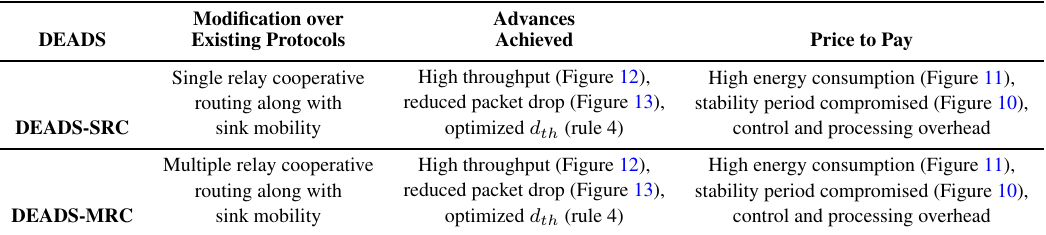
Table 3. Performance tradeoffs made by routing